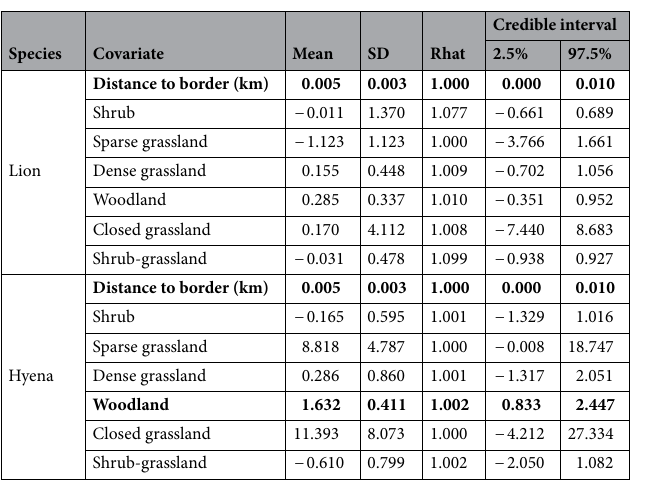
Table 1. Covariates influencing abundance of lions and spotted hyenas, Maswa Game Reserve, Tanzania, June–July 2017. Significant covariates are indicated in bold font. Mean = estimate mean, SD = Standard Deviation, Rhat = Gelman–Rubin convergence diagnostic, convergence occurs at Rhat =